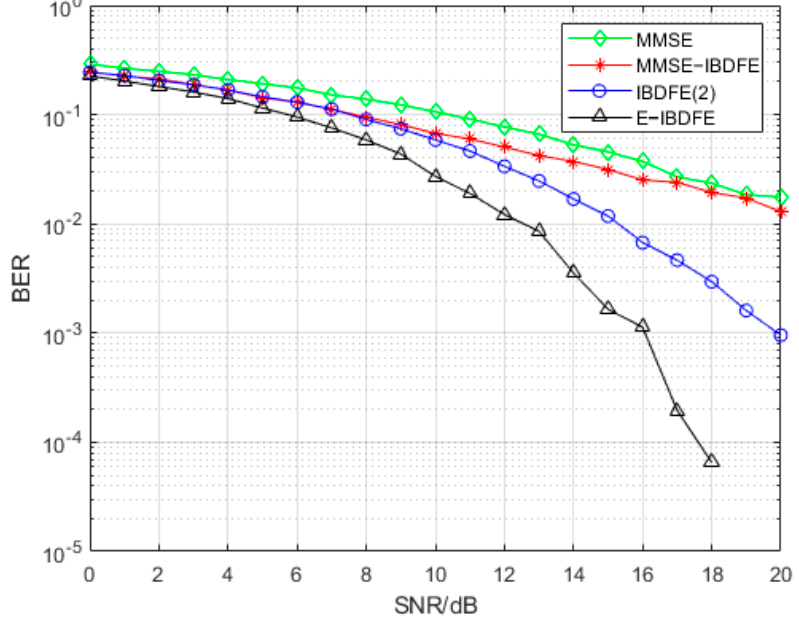
Figure 8. Comparison of BER of 4 equalization algorithms in EVA channel.